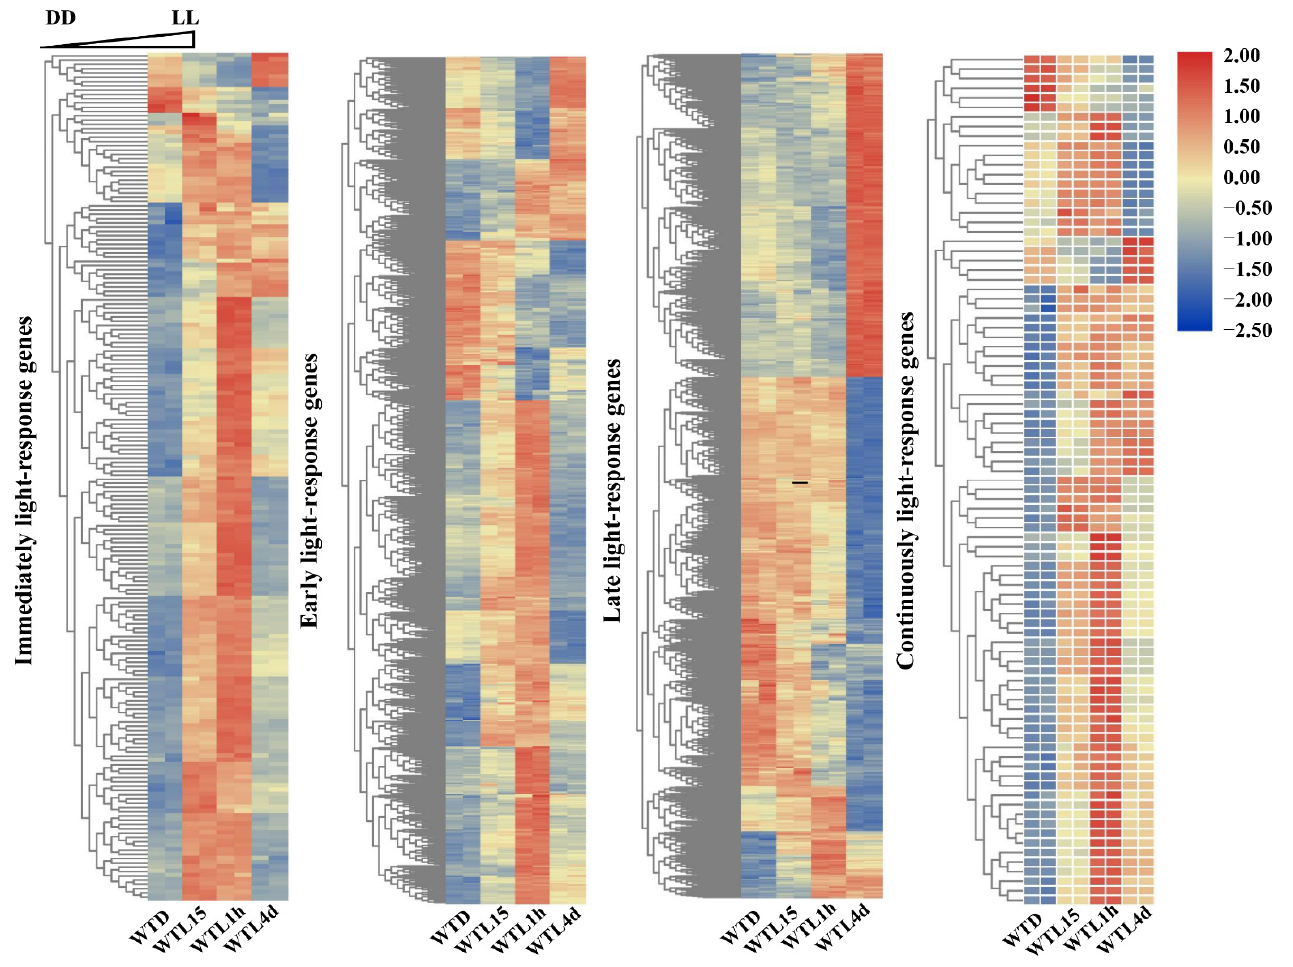
Figure 10. Classification of light-response genes. Immediately, early, late, and continuously light- responsive genes respond to light after exposure for 15 min, 1 h, 4 d, and always from 15 min to 4 d, respectively. For each lane, from left to right, the individual columns correspond to light treatment for 0, 15 min, 1 h, and 4 d, respectively.